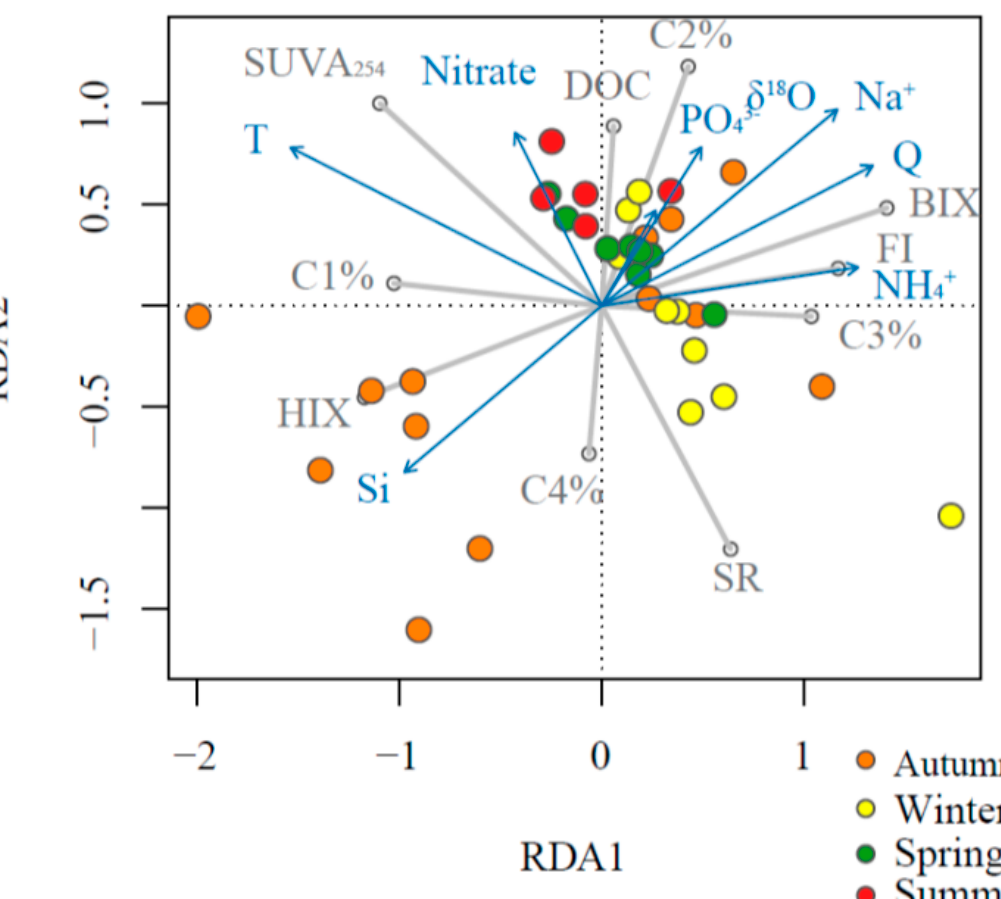
Figure 5. Redundancy analysis (RDA) plot of environmental variables as predictors for stream water DOM properties in the Mayfield Creek. Blue arrows denote predictors, grey lines denote dependent variables, and colored circles represent samples of different seasons.